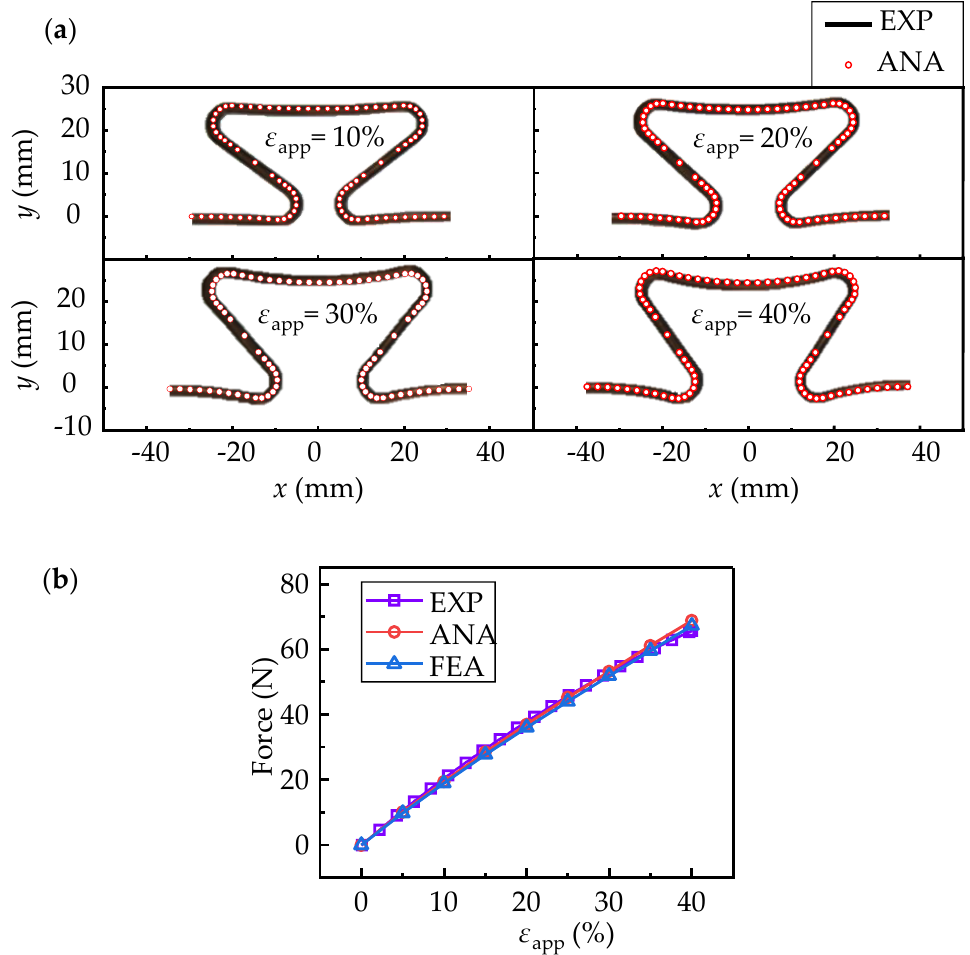
Figure 7. The comparisons between experiments and analytical results: ( a ) deformed configurations with applied deformations of 10%, 20%, 30% and 40%, respectively; ( b ) force variations with applied deformations. The square, round and triangle signs represent results from experiment, analytical model and FEA, respectively.